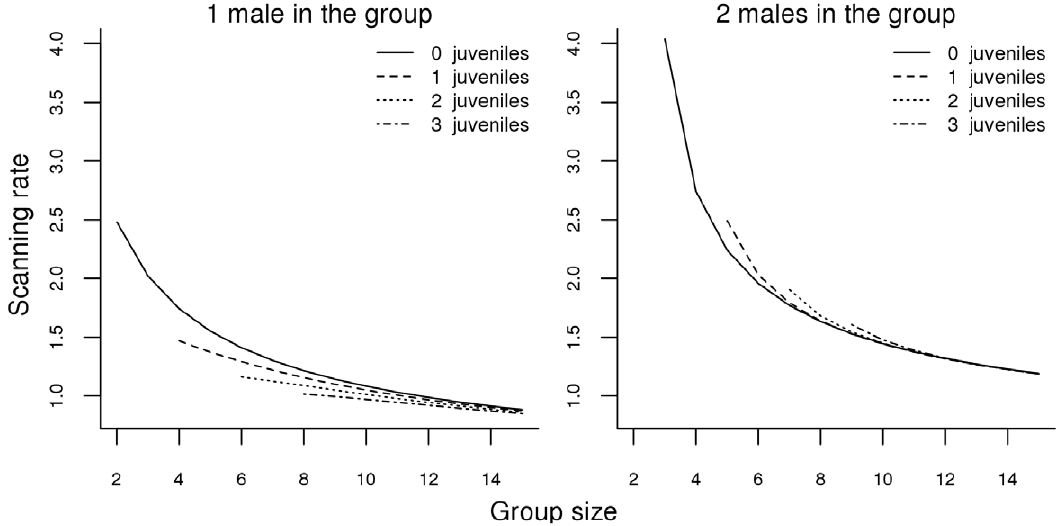
Figure 3. Changes in scanning rates (vigilant acts per minute) as a function of group size, number of juveniles and number of males in the group for adult males according to model 6 (LMI security model with mothers accompanied by juveniles).